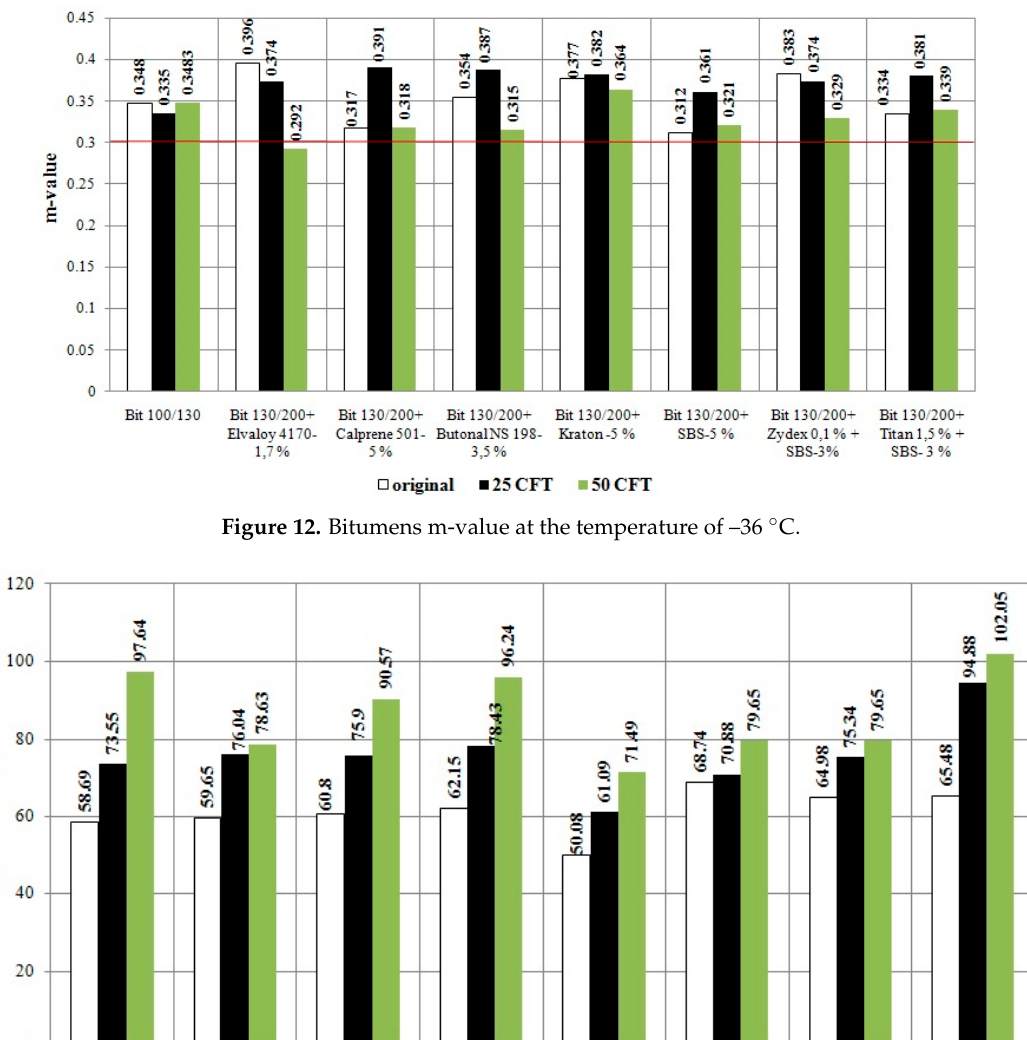
Figure 11. Bitumens m-value at the temperature of –30° С .